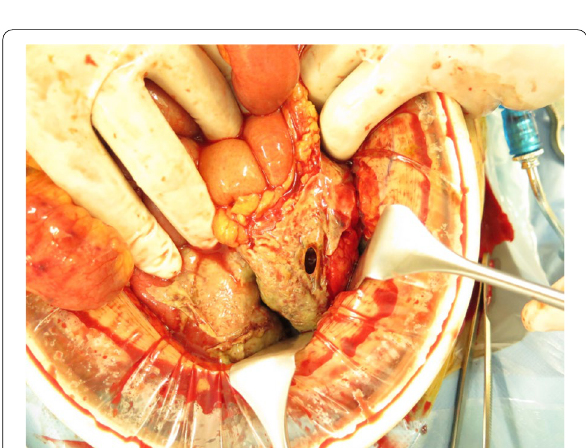
Fig. 2 Intraoperative findings. A 2-cm perforation is found in the sigmoid